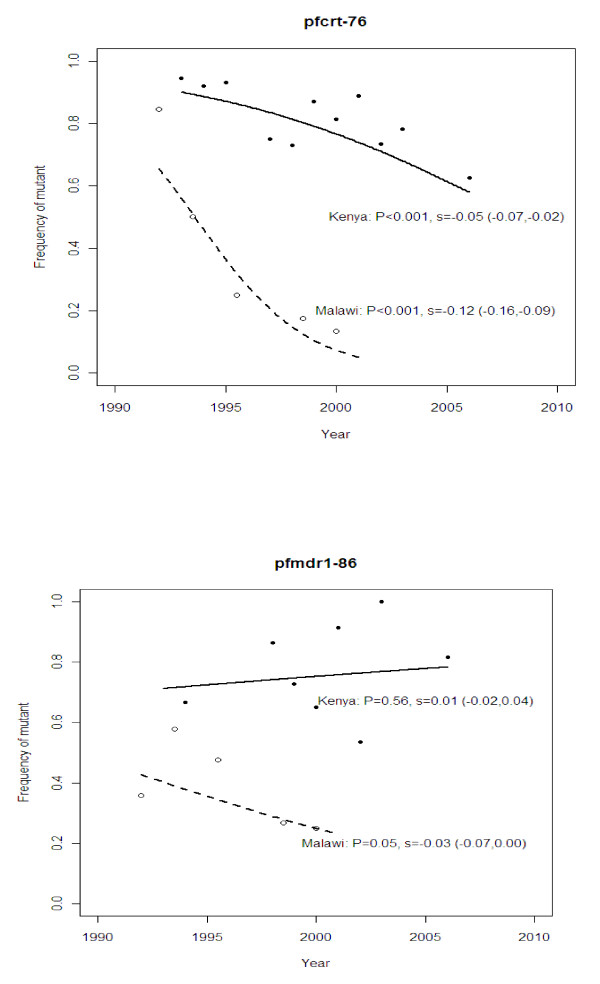
Observed and fitted (by logistic regression) frequencies of pfrt-76 and pfmdr1–86 through time in Kilifi, Kenya and a study in Malawi [3]. Observed (symbols) and predicted (lines) population frequencies through time of alleles pfcrt-76 (top panel) and pfmdr1–86 (bottom panel) involved in resistance to chloroquine in Kenya (solid line, closed symbols) and Malawi (dashed line, open symbols) before and after the official ban on the use of chloroquine (1999 and 1992, respectively). The P-value indicates whether the slope of the predicted line is significantly different from zero. The selection coefficient (s) of the resistant allele relative to the wild-type allele is shown with its 95% confidence intervals for each location.